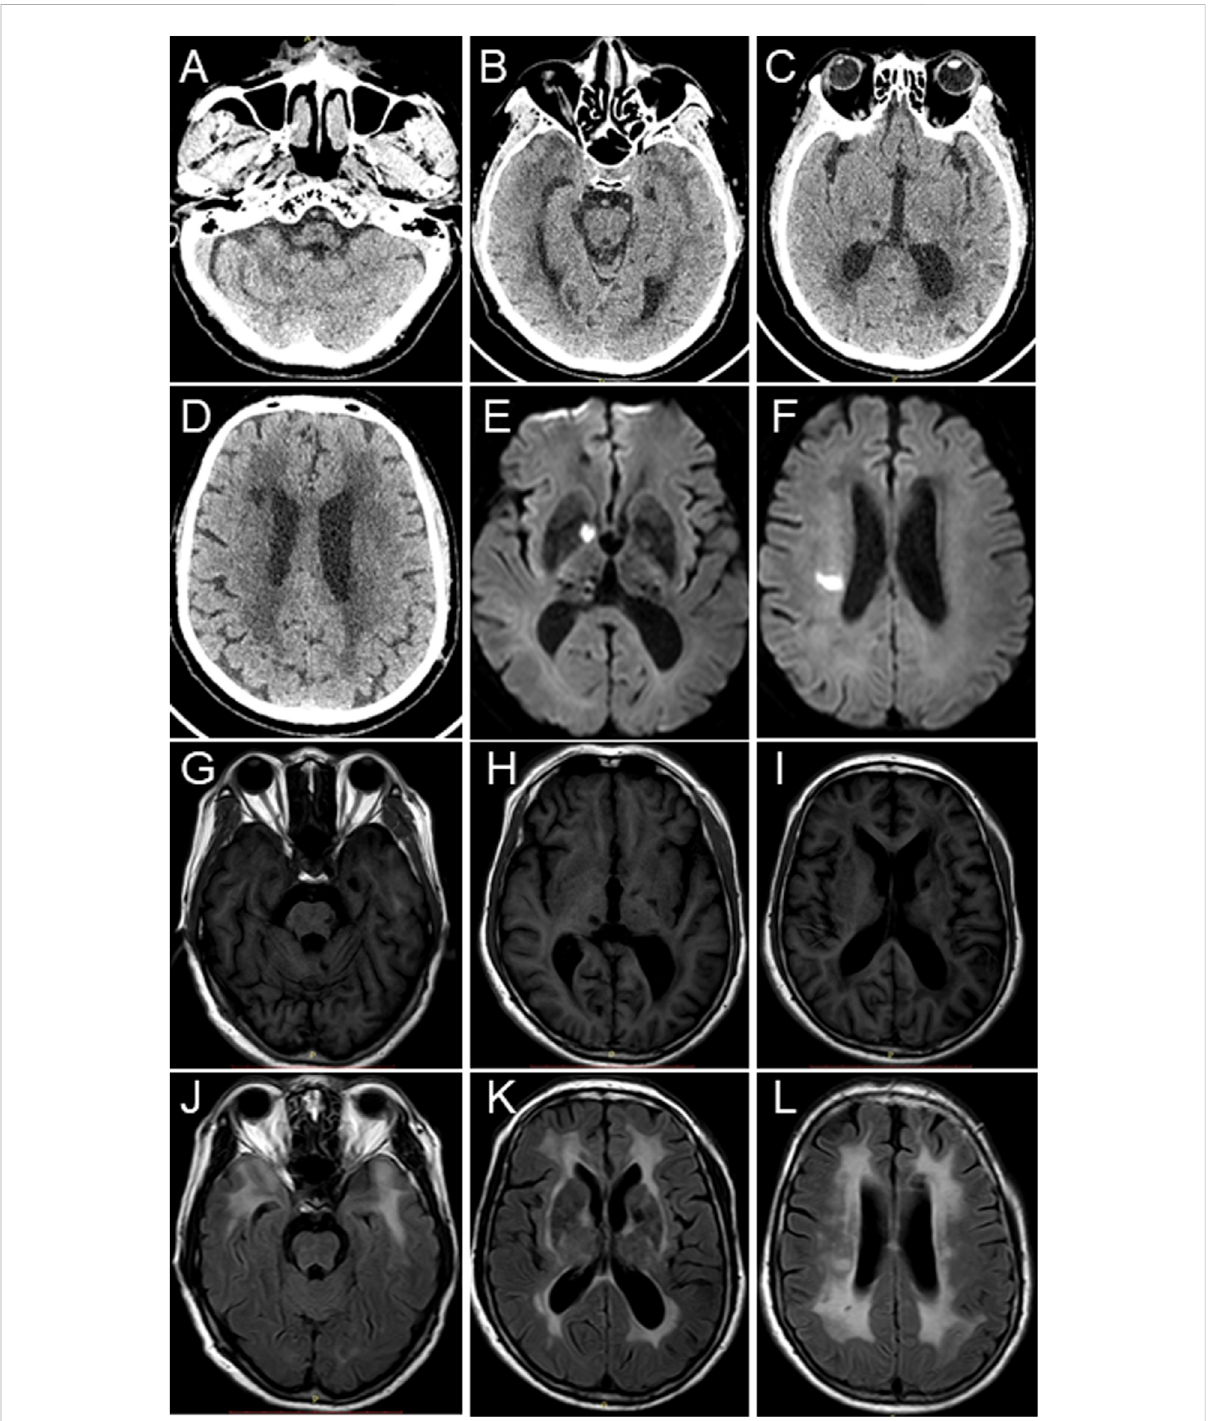
FIGURE 1 Brain CT scan and MRI images of the proband. (A – D) Brain CT scan suggests multiple lacunar cerebral infarctions, white matter degeneration, and brain atrophy. (E,F) Brain MRI-DWI shows signi fi cant hyperintensity signals. (G – I) Decreased signal intensities were observed in the brain stem, basal ganglia, and thalamus in the T1-weighted MRI images. (J – L) T2-weighted and fl uid-attenuating inversion recovery (FLAIR) brain MRI revealed symmetrical white matter lesions in the temporal pole, outer capsule, lateral ventricle, and deep